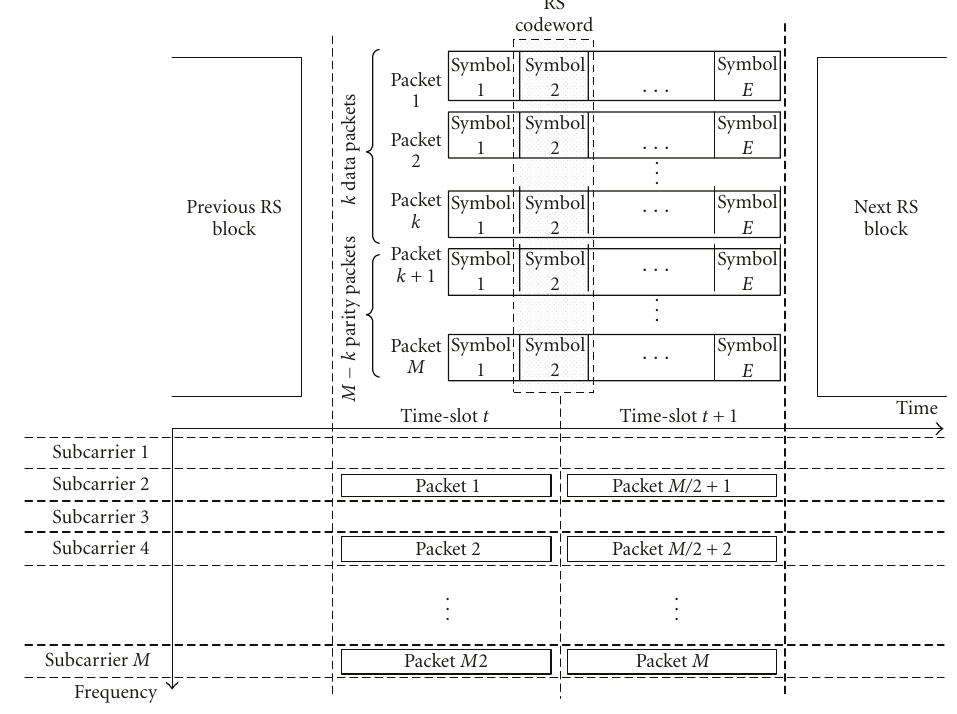
Figure 13: Transmission of RS-coded packets for EECOMP.